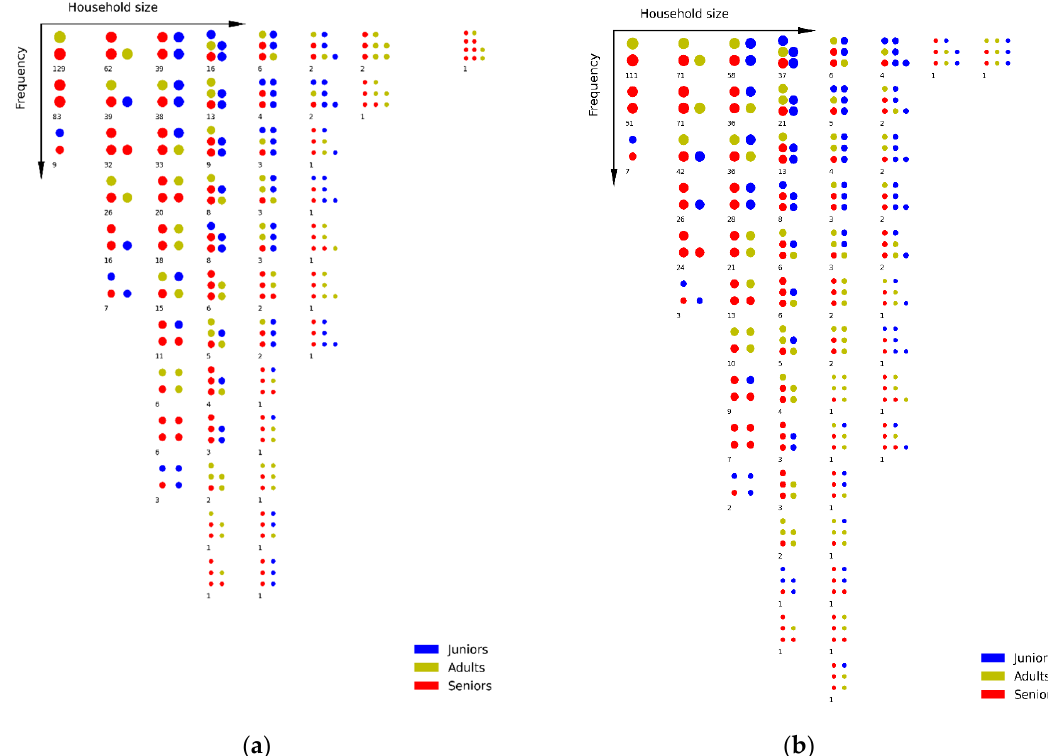
Figure 6. Distribution of household types with total costs higher than the states’ hotel quarantine cost: ( a ) in NSW; and ( b ) in WA, when the total cost of home isolation is greater than the states’ hotel quarantine cost. Household members are represented with a circle coloured by age category and households are represented by clusters of circles. Larger circles indicate more common household types. “Juniors” refer to individuals under the age of 20; “adults” are defined as individuals between 20 and 59 years old, and “seniors” refers to those aged 60 and older.